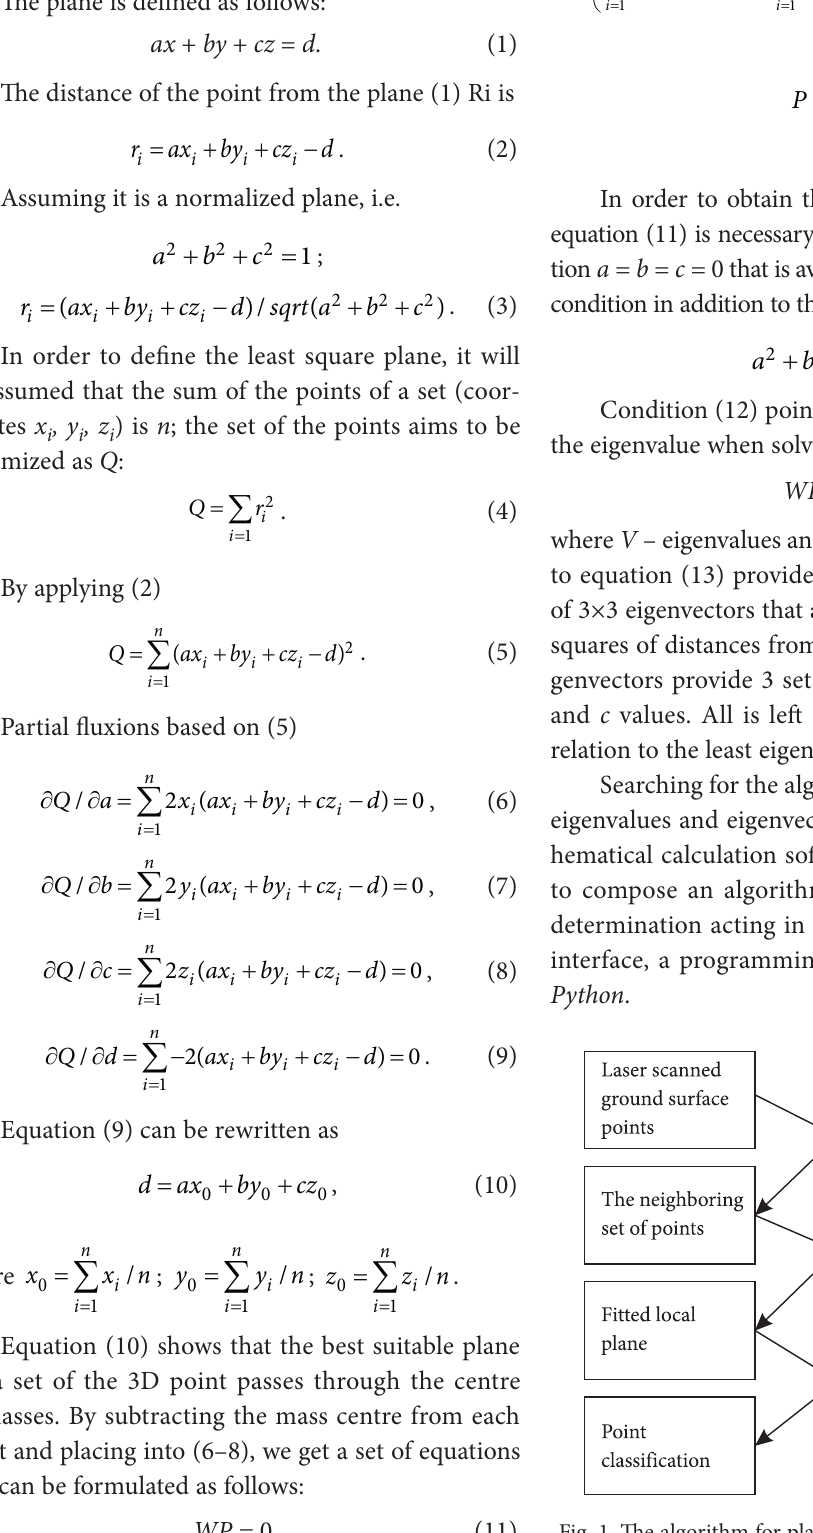
Fig. 1. The algorithm for plane fitting and point